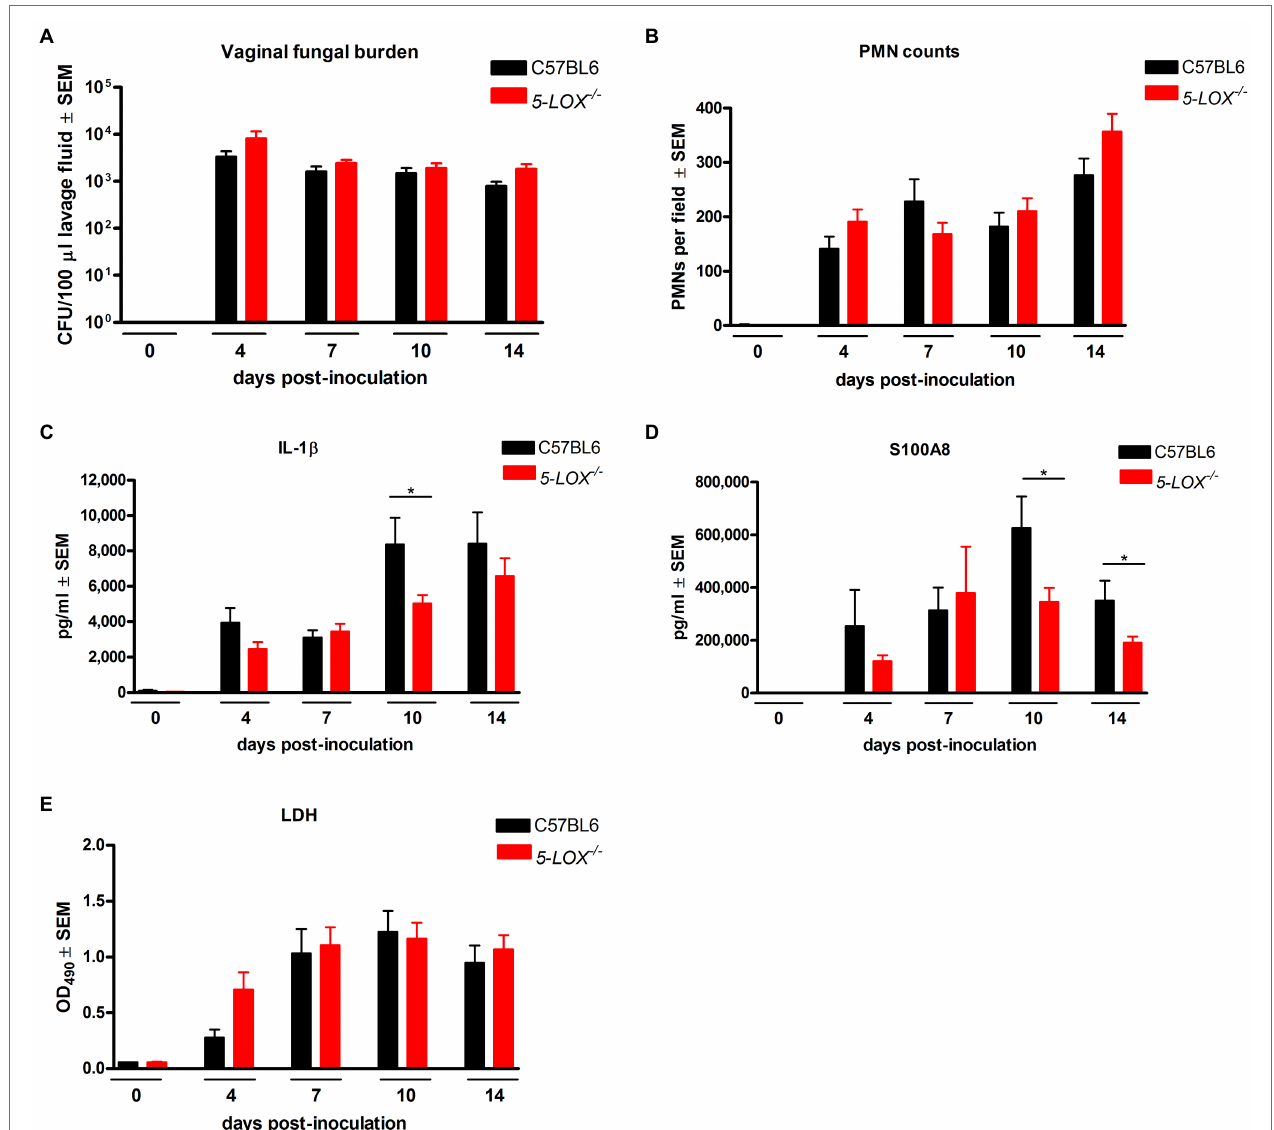
FIGURE 4 | 5-lipoxygenase/leukotriene pathway is not required for vaginal immunopathology during VVC. Estrogenized C57BL6 wild-type (C57BL6) or 5-lipoxygenase deficient ( 5-LOX − / − ) mice were intravaginally inoculated with 5 × 10 6 C. albicans SC5314. Vaginal lavage fluid was collected longitudinally over a period of 14 days post-inoculation. (A) Vaginal fungal burden was assessed by quantitative plate counts at the indicated time points. (B) Vaginal cellular infiltrates were stained by the Pap smear technique and examined by light microscopy at x400 magnification. Number of PMNs were quantified in 5 nonadjacent fields per sampled and averaged. Levels of (C) IL-1 β and (D) S100A8 in vaginal lavage fluid were quantified by ELISA. (E) LDH release in vaginal lavage fluid was measured as an indicator of tissue damage. Data represent cumulative results of 2 independent experiments performed with 5–15 animals/group. Data were analyzed by using the unpaired Student’s t test comparing the 5-LOX knockout group with the wild-type control group at specific time points. * p < 0.05. CFU, colony-forming unit; PMN, polymorphonuclear leukocyte; LDH, lactate